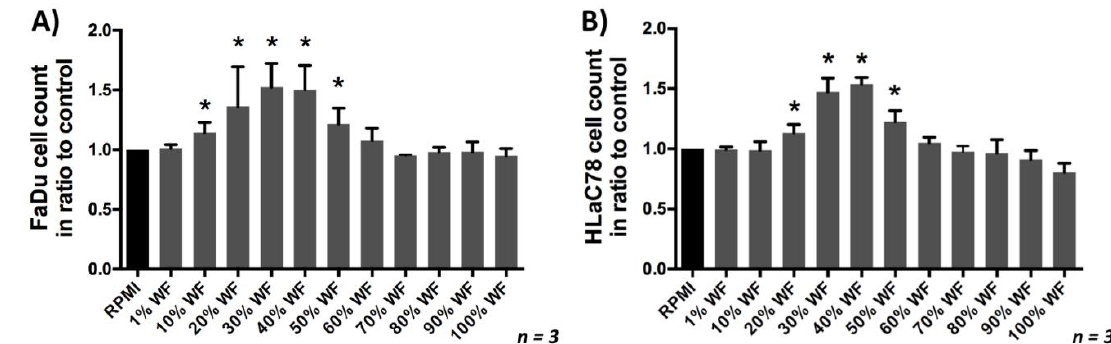
Figure 3. ( A ) FaDu and ( B ) HLaC78 growth in dependence of the WF concentration: The maximum cell proliferation in dependence of WF concentration was reached by incubating with RPMI medium supplemented with 30% and 40% WF ( n = 3). Significant differences compared to the control (RPMI) were marked with an *.